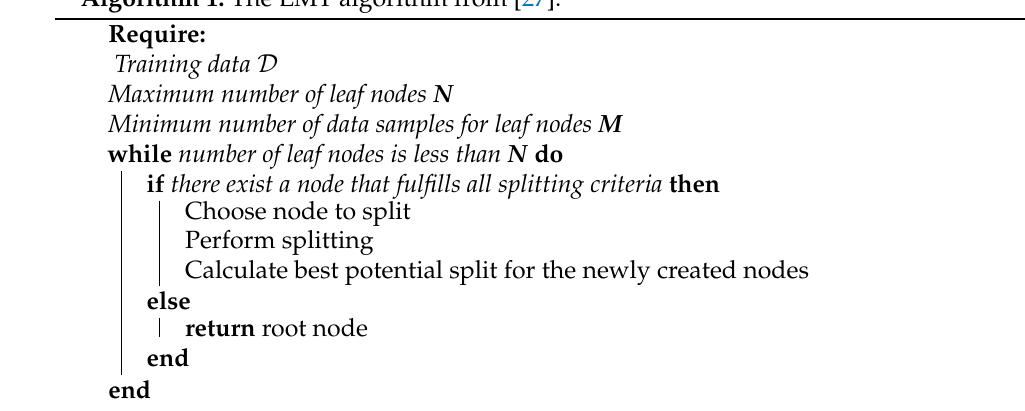
Algorithm 1: The LMT algorithm from